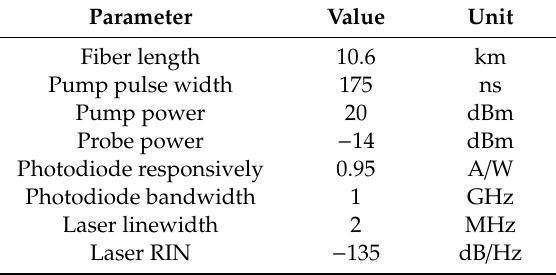
Table 1. Experimental parameters.